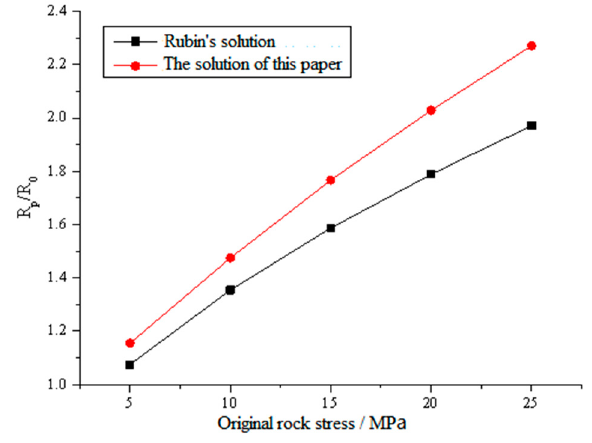
Figure 6. Plastic range under different original rock stress.